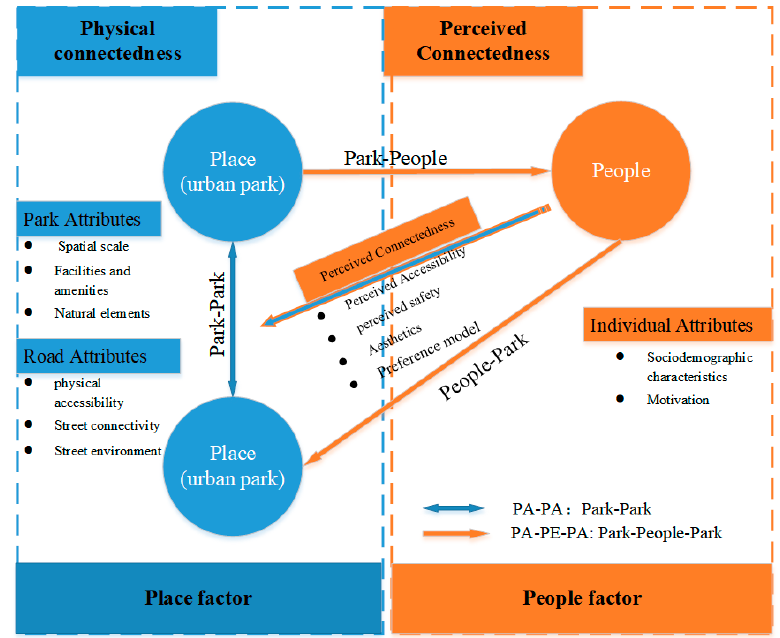
Figure 9. The relationship between physical and perceived connectedness.